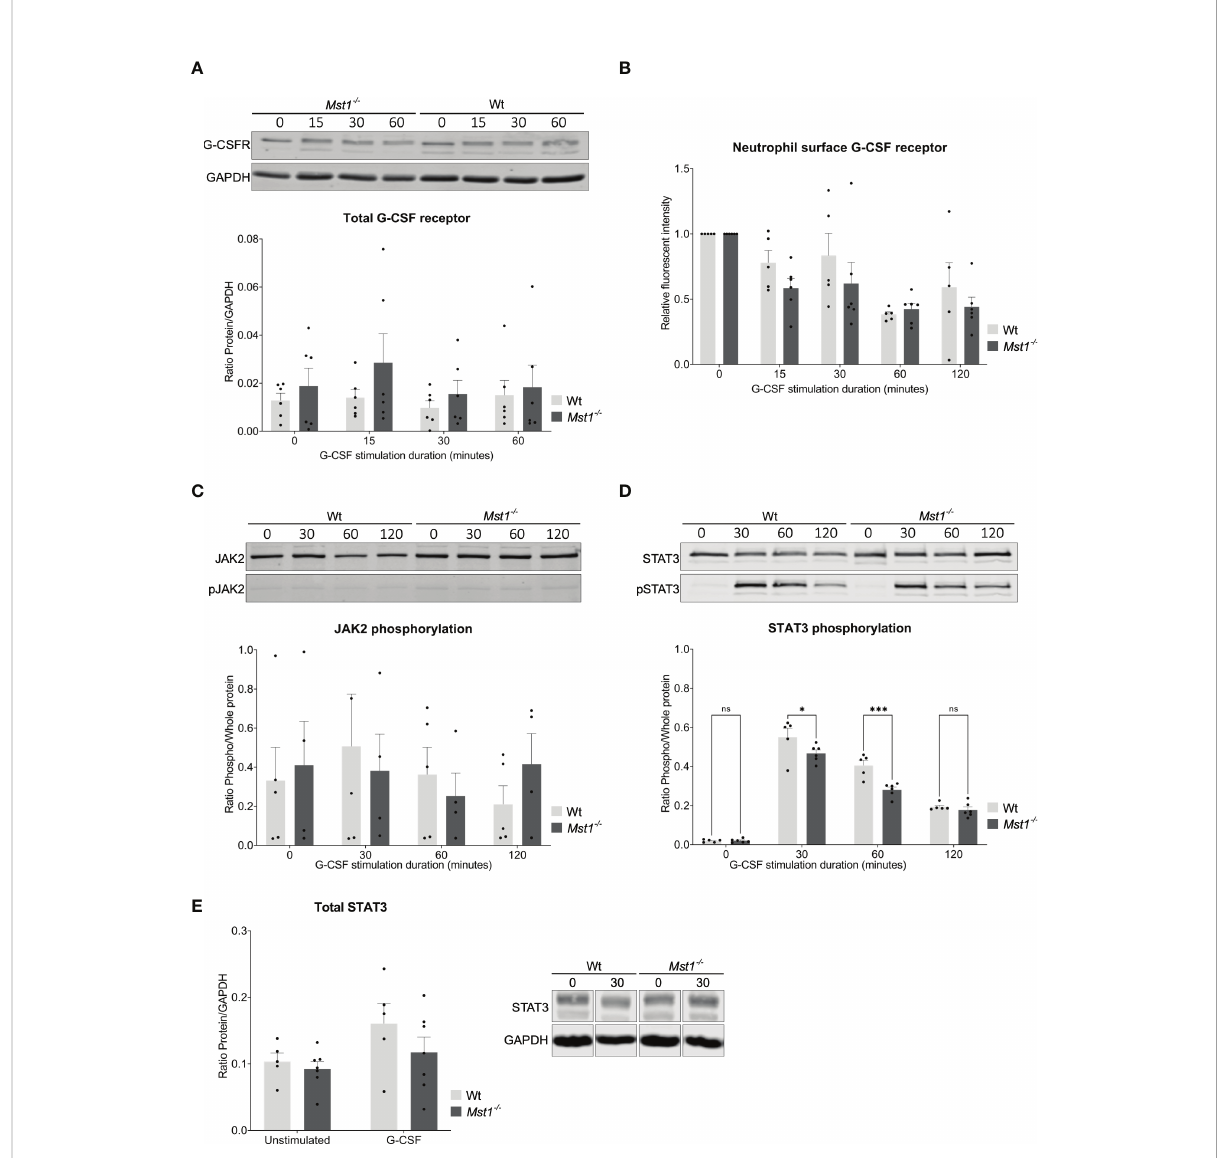
FIGURE 3 STAT3 phosphorylation reduced in Mst1 -/- neutrophils after G-CSF stimulation. (A) Western blot analysis of total G-CSFR levels in unstimulated and G-CSF stimulated puri fi ed bone marrow neutrophils normalised to GAPDH; n=6. (B) Fold change of membrane levels of G-CSFR in G-CSF stimulated relative to unstimulated bone marrow neutrophils; n=5. (C) Neutrophil JAK2 phosphorylation normalized to total JAK2; n=5. (D) Neutrophil STAT3 phosphorylation normalized to total STAT3; n=5. (E) Total levels of STAT3 analysed by western blot in unstimulated and 30 minute G-CSF stimulated puri fi ed bone marrow neutrophils from WT and Mst1 -/- mice; n=5. Two-way ANOVA; ns, non signi fi cant; *p<0.05,